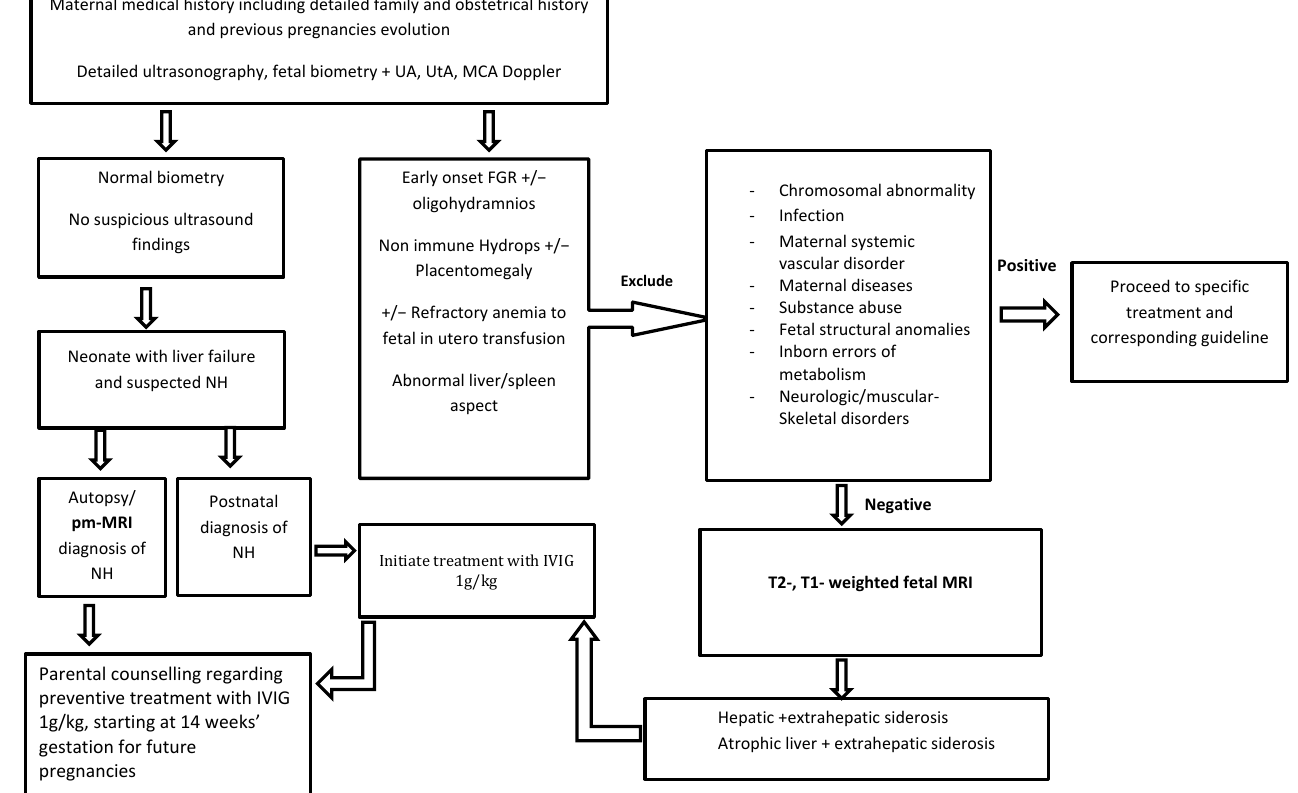
Figure 3. Prenatal diagnosis algorithm proposal for suspected neonatal hemochromatosis in the first affected